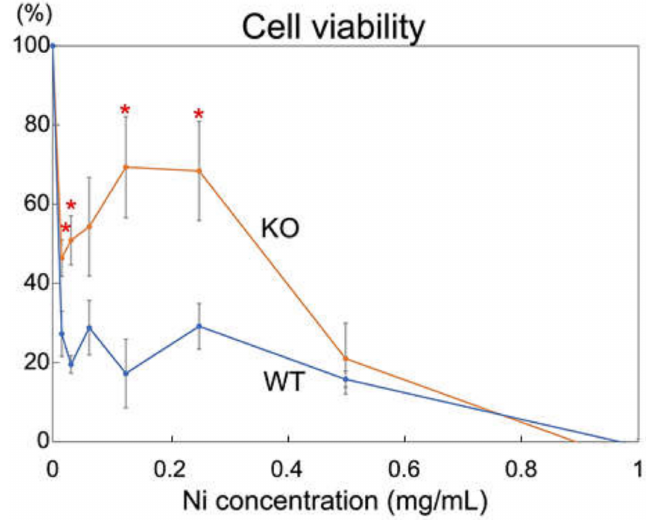
Figure 3. Sensitivity of macrophages to nickel solution. Bone marrow-derived macrophages derived from wild-type (WT) and Rab44-knockout (KO) mice were incubated with the indicated concentra- tions of Ni 2 SO 4 solution for 24 h. Viability was determined using a Cell Counting Kit. * p < 0.05 compared to WT